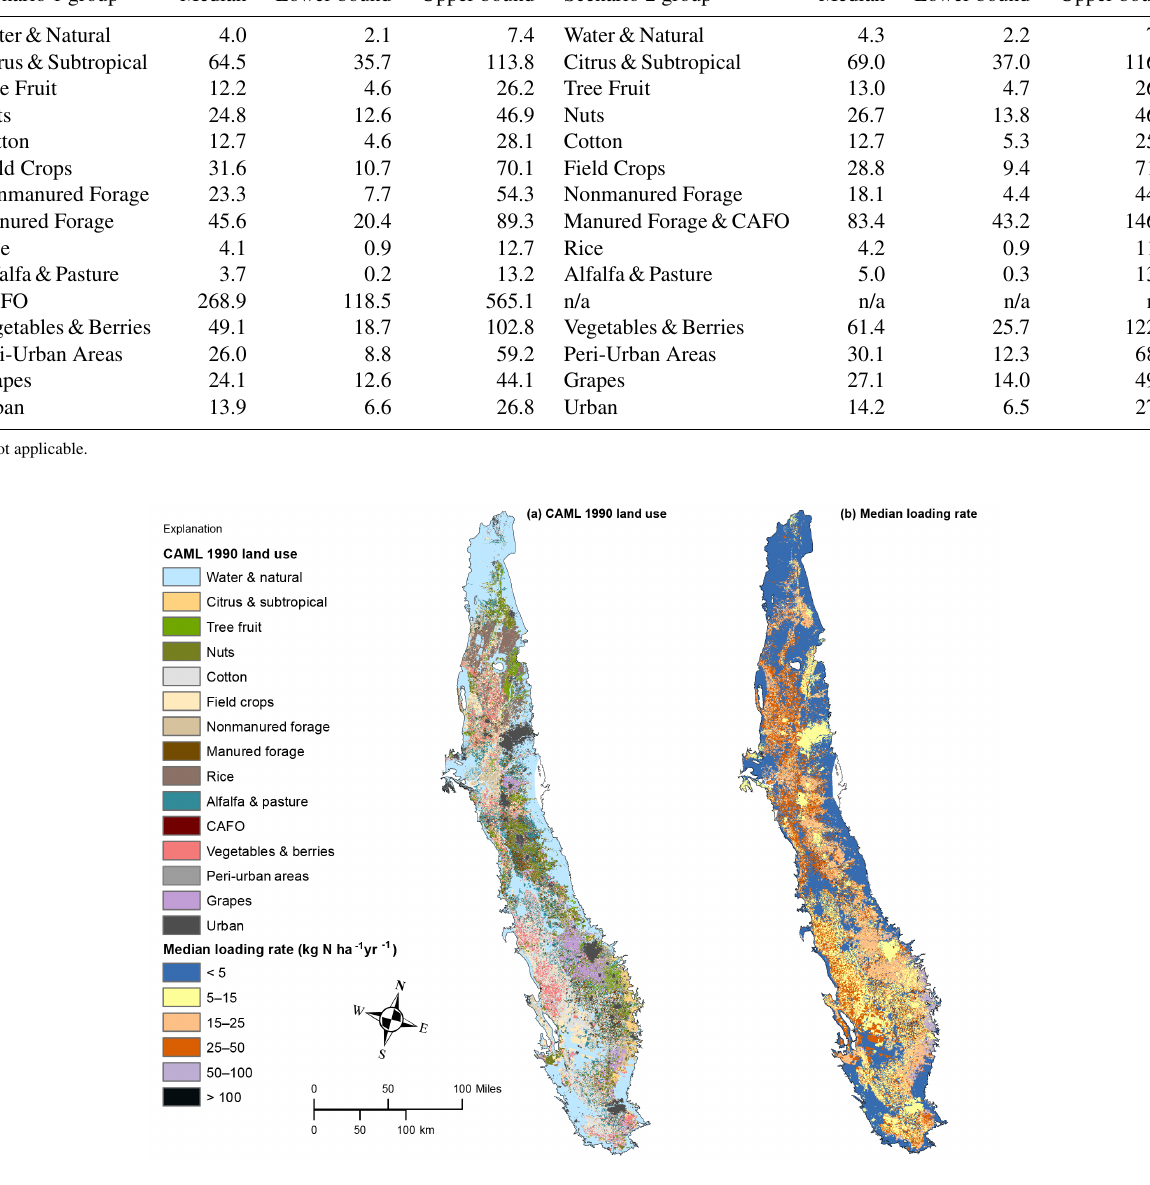
Figure 6. CAML land use for the 15 land-use groups in scenario 1 (a) and the same land-use groups keyed to the median estimated nitrogen loading rate in kgNha − 1 yr − 1 for the corresponding group (b)